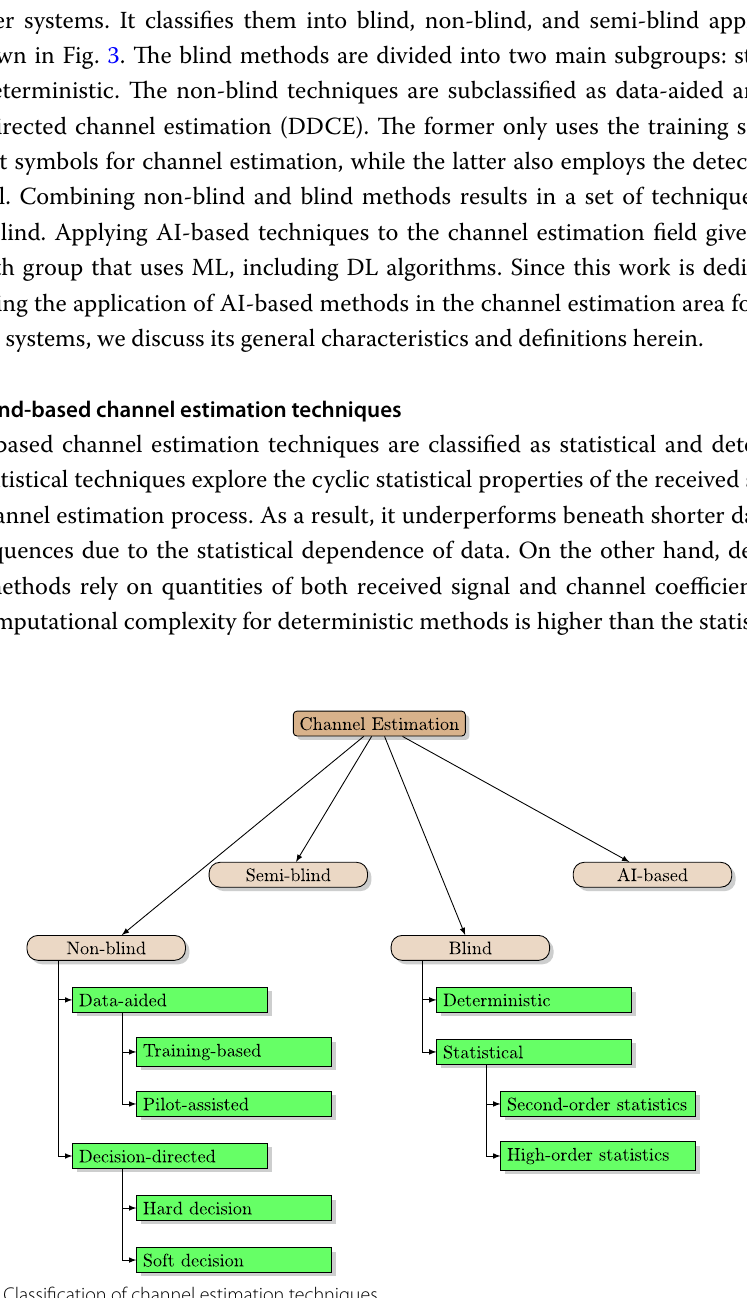
Fig. 3 Classification of channel estimation